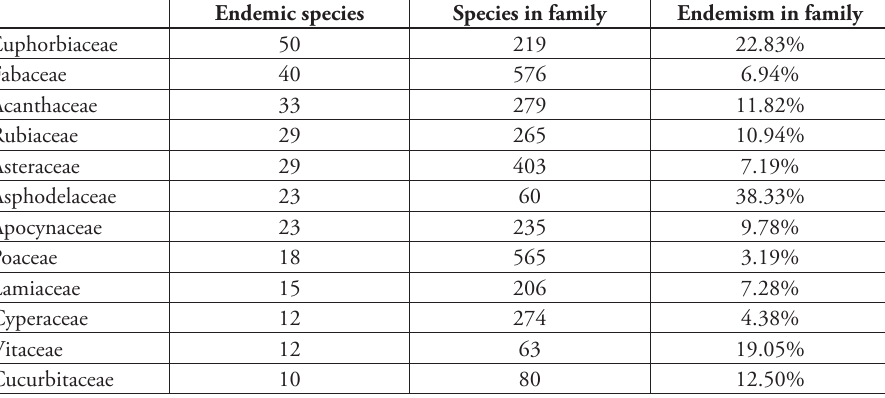
Table 2. The number of endemic plant species and total species of the top 12 families. Endemic species Species in family